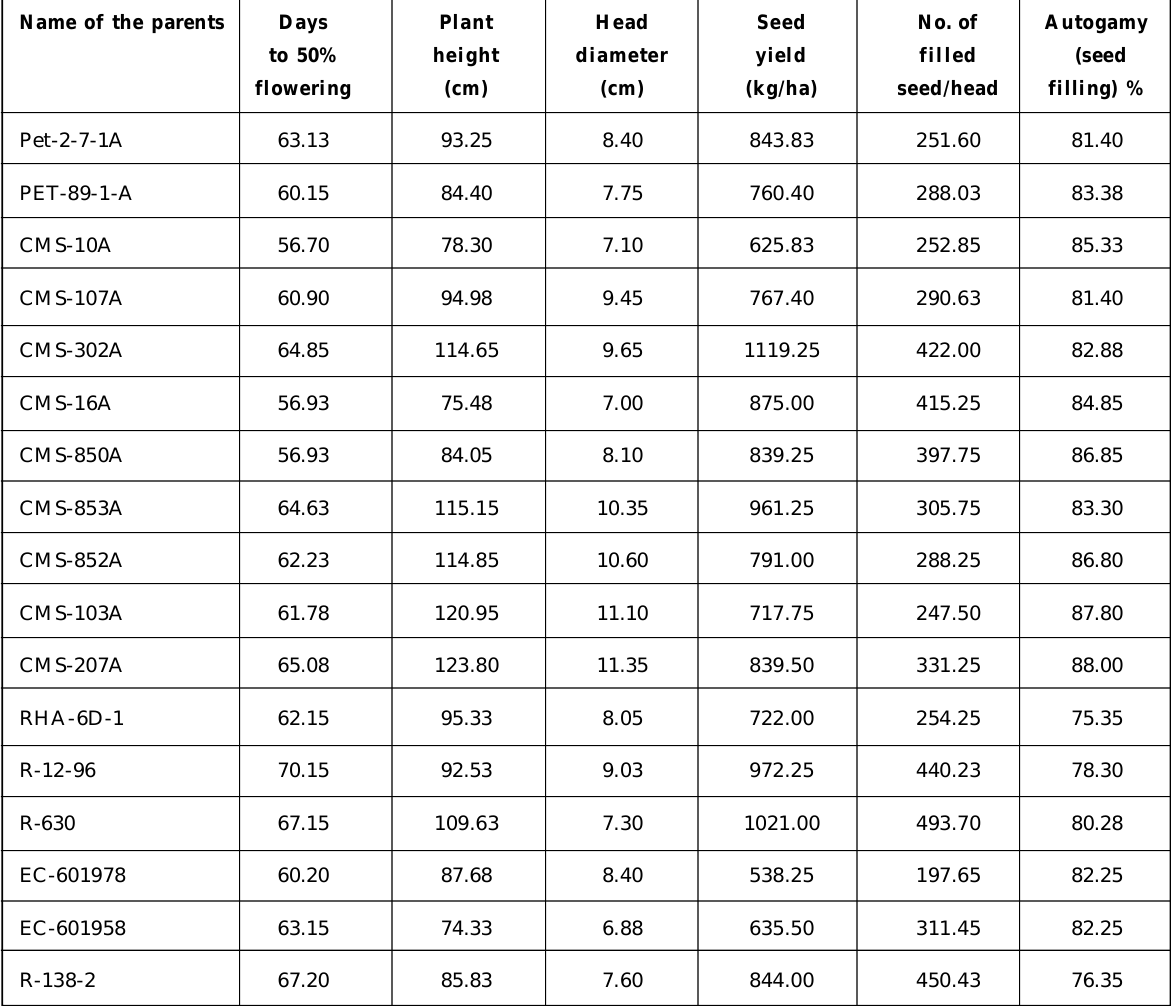
Table 2: Mean values for yield attributing traits of 32 genotypes in sunflower